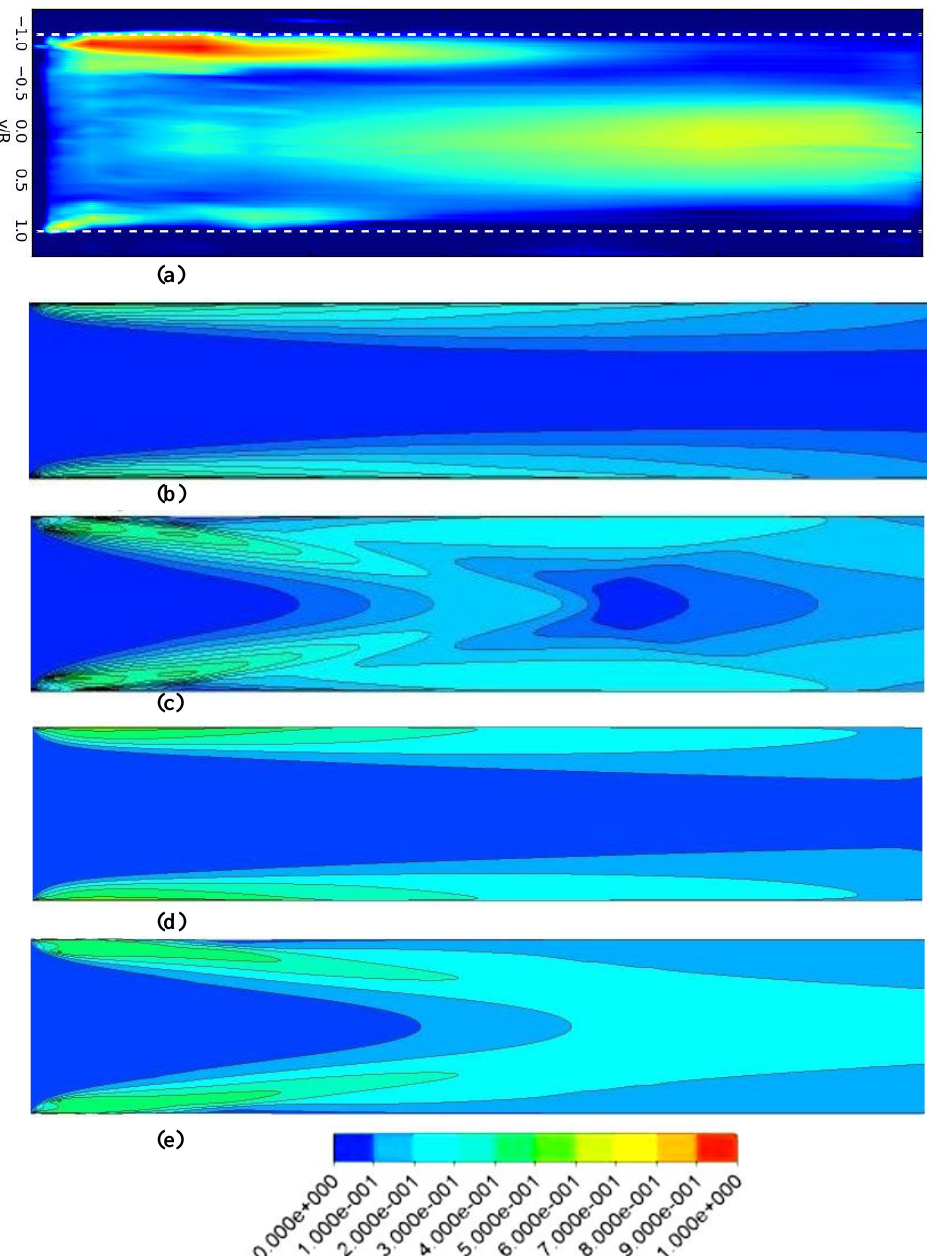
Figure 13. Comparison between the experimental and CFD predicted results to check the influences of vapor compressibility. ( a ) X-ray radiography measurement at CN = 11.2 [15], ( b ) SS model, incompressible, n B = 10 10 , ( c ) SS model, compressible, n B = 10 10 , ( d ) ZGB model, incompressible, α = 0.0001, ( e ) ZGB model, compressible, α = 0.0001.